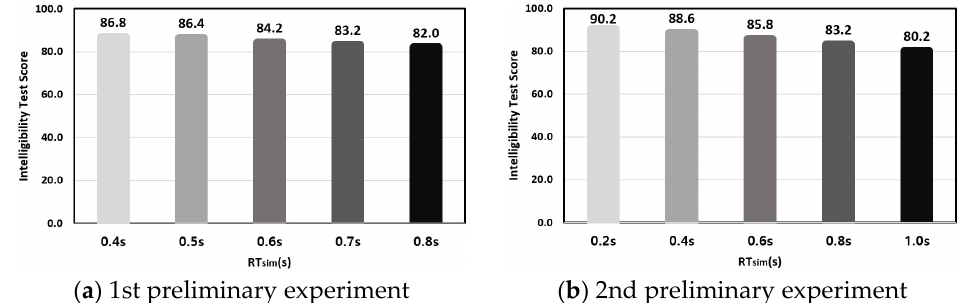
Figure 8. Preliminary experiment results of ( a , b ).